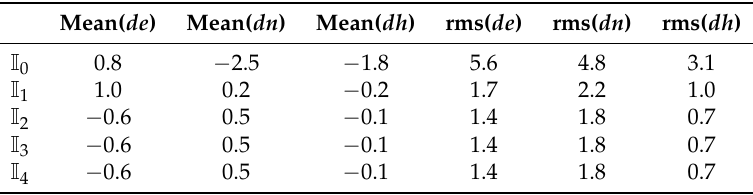
Table 7. Corresponding results (units of [mm]) in numbers for Figure 9b. Mean( de ) Mean( dn ) Mean( dh ) rms( de ) rms( dn ) rms( dh